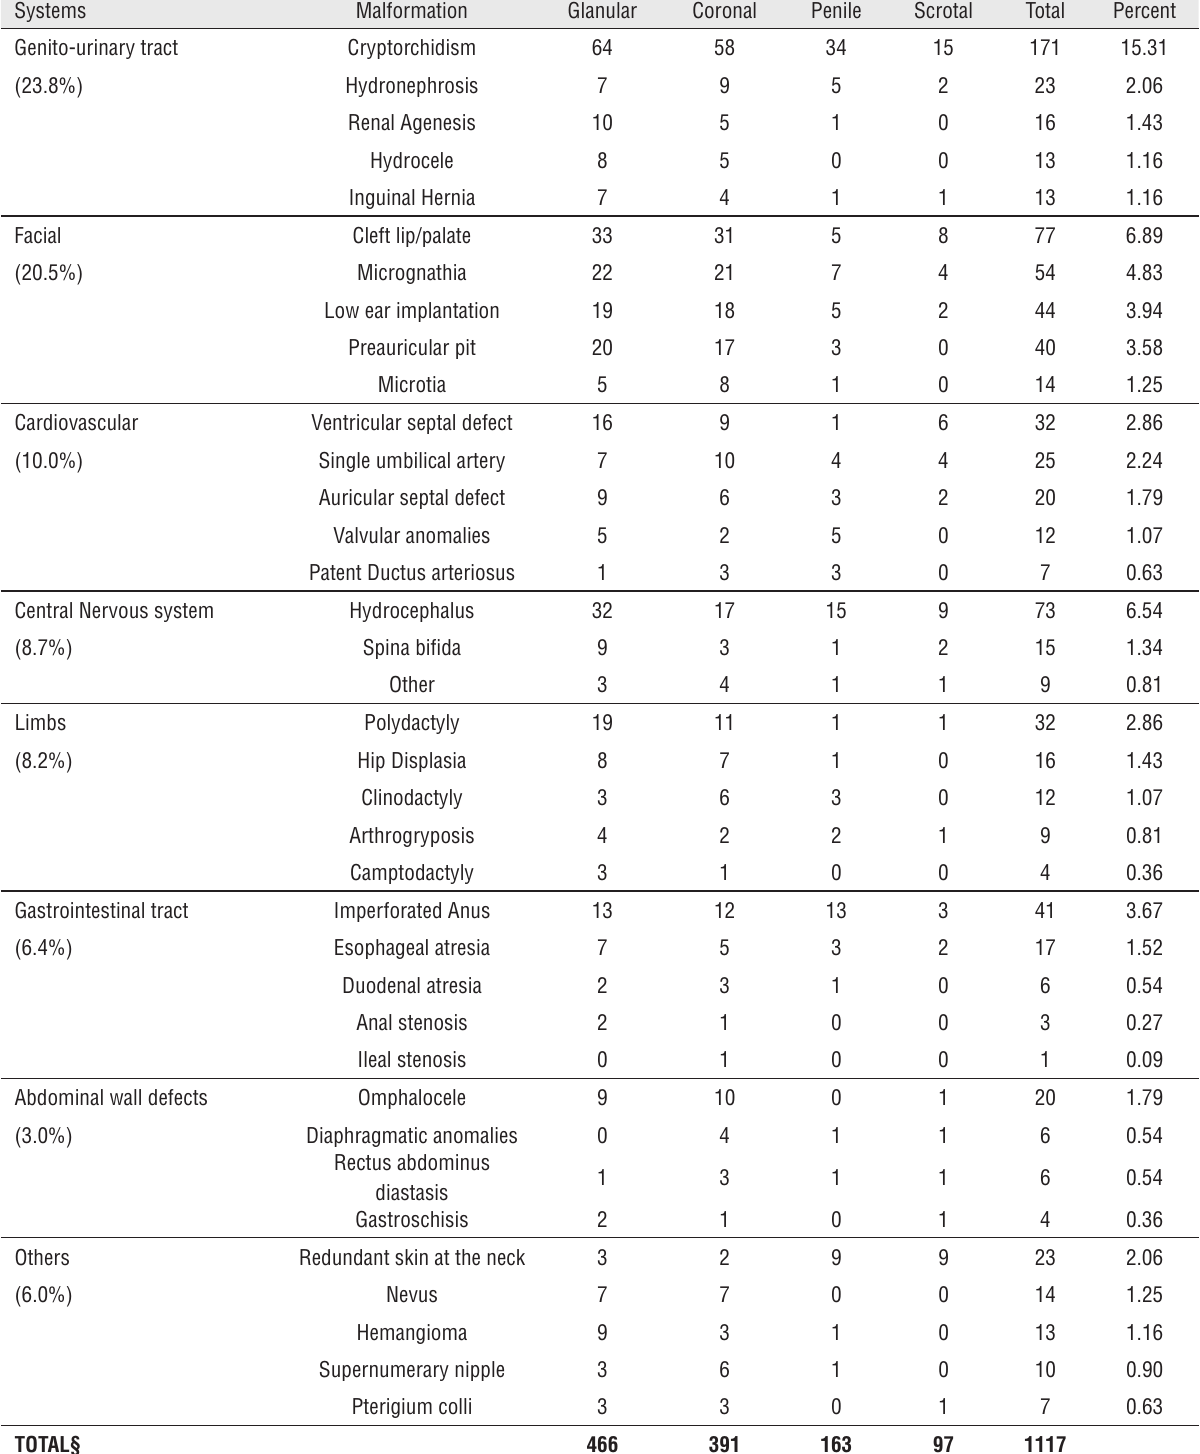
Table 2 - Five most common associated anomalies by system and its distribution according to the severity of hypospadias.